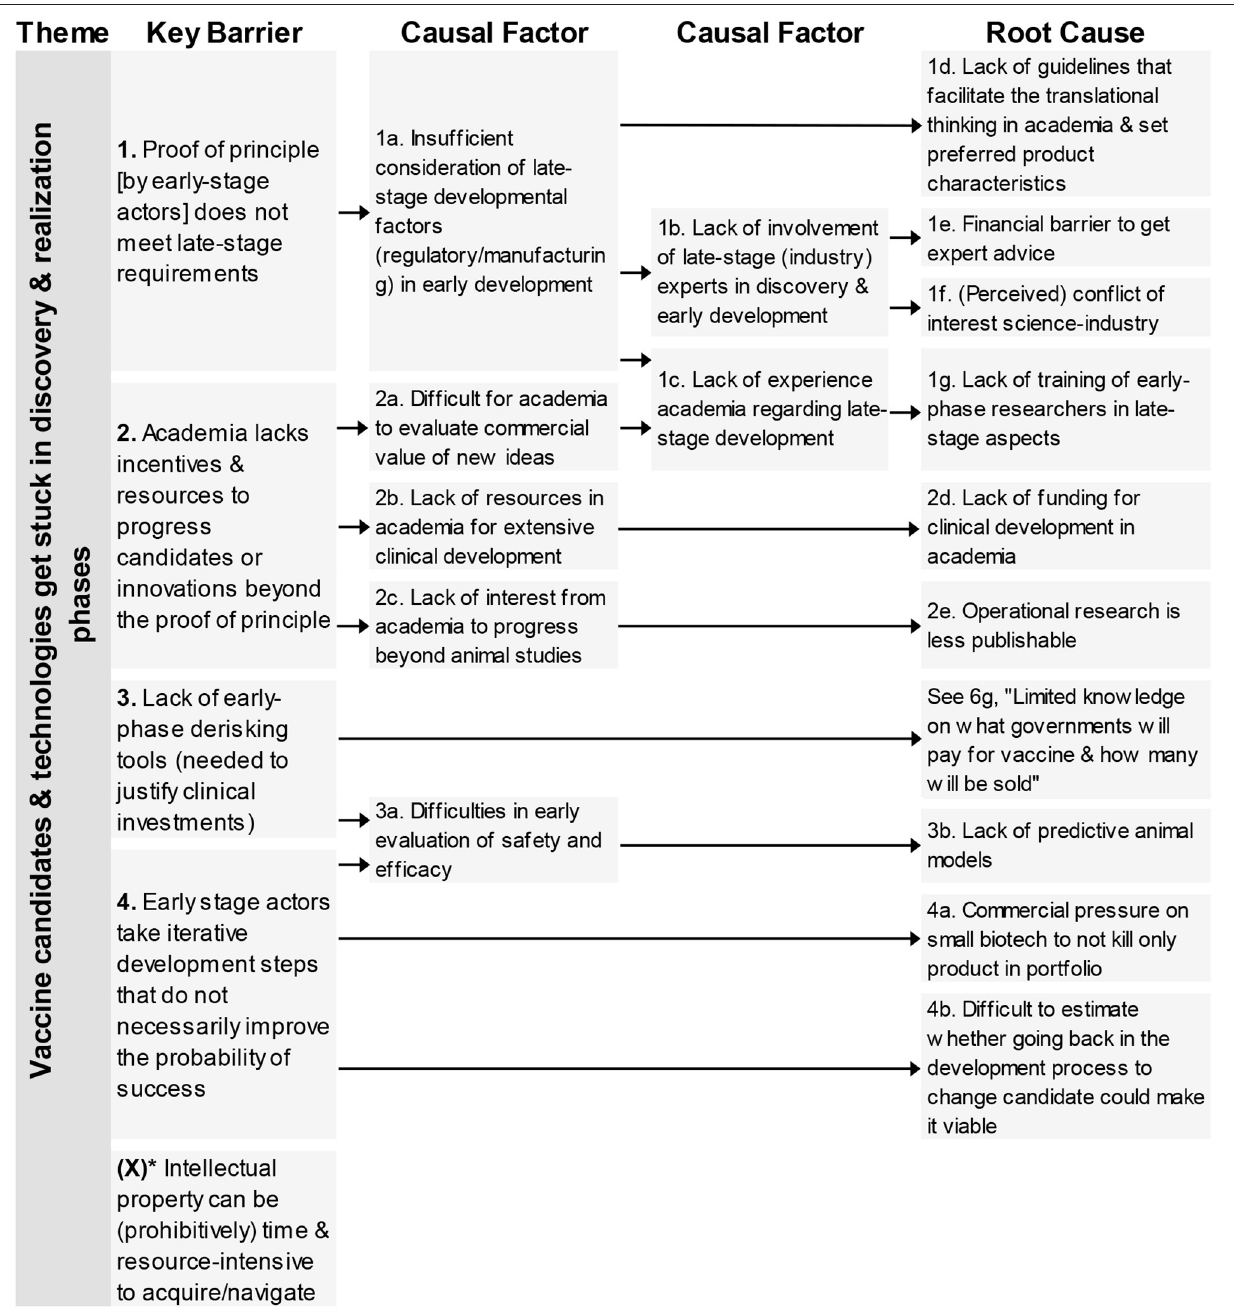
FIGURE 1 | Root-cause analysis of the four key barriers classified under the theme “Vaccine candidates & technologies get stuck in discovery & realization phase.” Columns are causally structured. (Left) key barriers are listed that are caused by causal factors (middle), which in turn find their origin in root causes (right). *Key Barrier X was added based on questionnaire